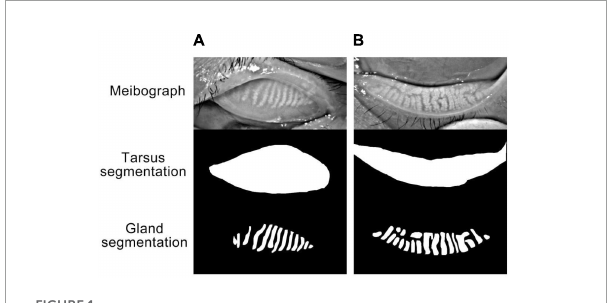
FIGURE1 (A,B) Represented the upper eyelid and lower eyelid, respectively. “Meibograph” demonstrated the representatives of original infrared photographs obtained with OCULUS. The meibomian gland area (%) is calculated as the ratio of the meibomian gland and tarsus area. “Tarsus segmentation” and “Gland segmentation” represented the segmentation results of the tarsus and meibomian glands area from the meibograph by the deep learning